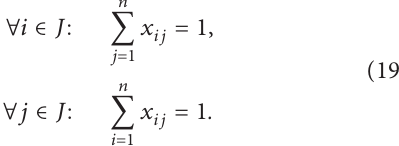
Phase 1 . First, an Initial Solution Set (ISS) is determined based upon the execution of different simple